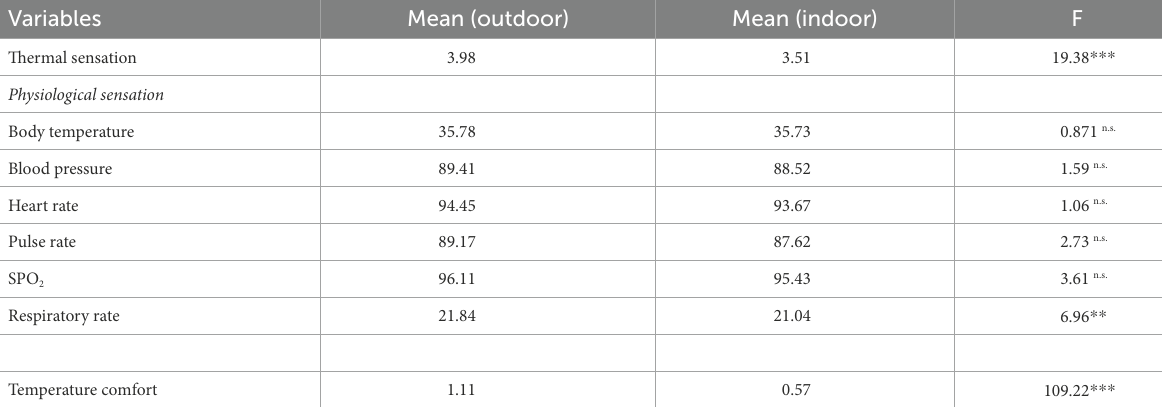
TABLE 5 Main effects of visual